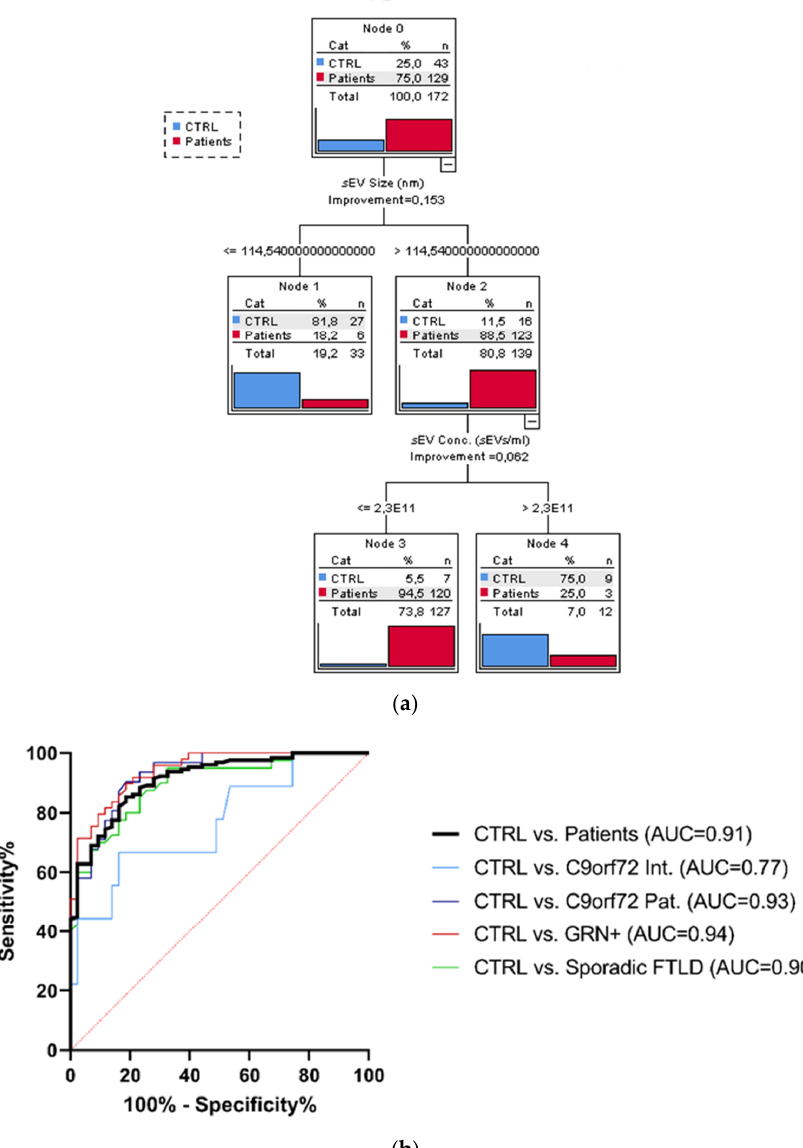
Figure 3. Classification tree and ROC curves. ( a ) Classification obtained with dichotomized group variables, controls (Ctrl) vs. all patients ( C9orf72 Int., C9orf72 Pat., GRN + Het., GRN + Homo., and Sporadic FTLD), based on the most predictive variables: sEV concentration and size, out of all biological variables associated with the groups. ( b ) Diagnostic capacity of sEV concentration/sEV size ratio to discriminate Ctrl from all patients. AUC comparison with DeLong test, ns p >